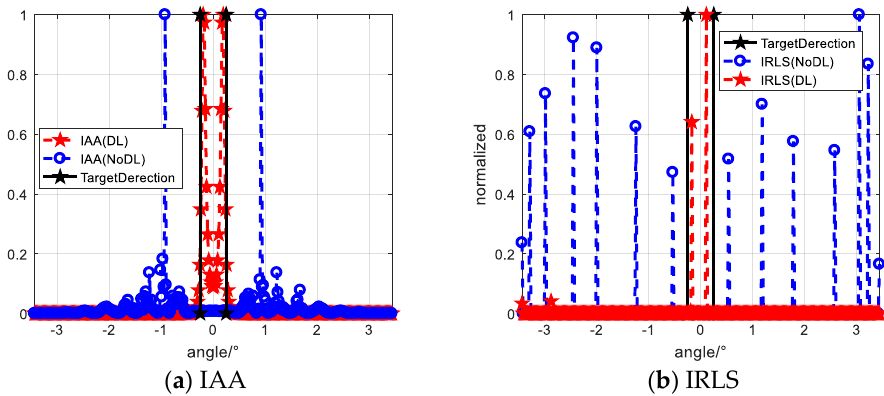
Figure 2. Comparison of the algorithms before and after diagonal loading (without interference).